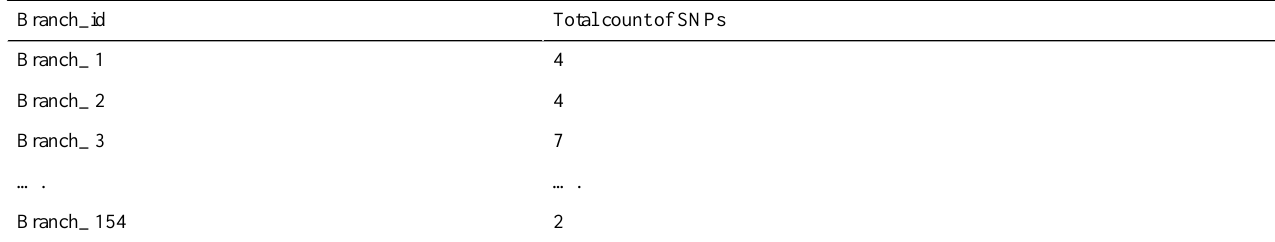
Table 8. Reference table for the probabilistic only SNP model.